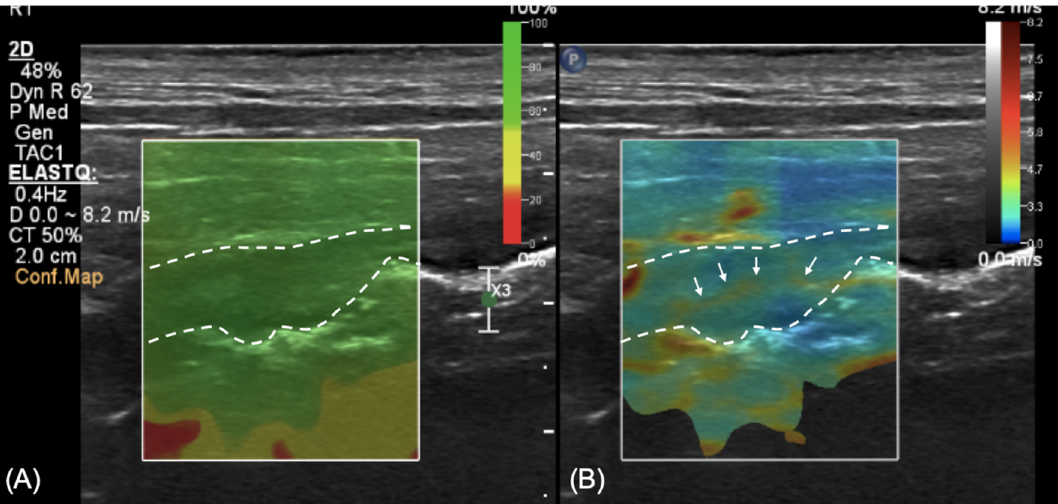
Figure 3. Shear-wave elastography at the level of the descending colon. ( A ) Confidence map to assess the reliability of the measurements; green color represents a reliable zone; ( B ) elastography at the level of the wall showing a predominance of blue areas (soft) with a yellow (harder) thin line running within it (arrows).